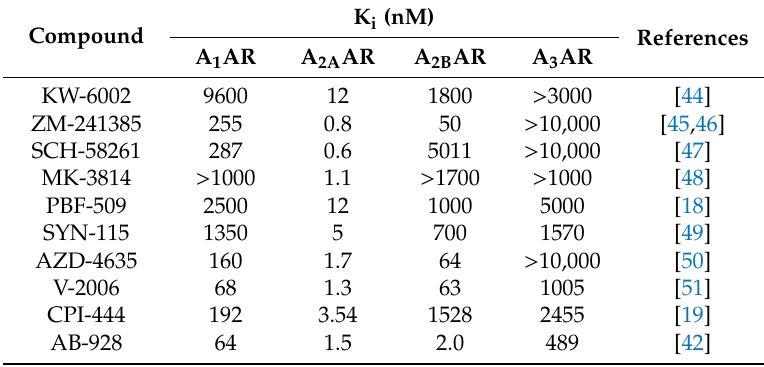
Table 1. A 2A AR antagonists and their a ffi nity for adenosine receptors.